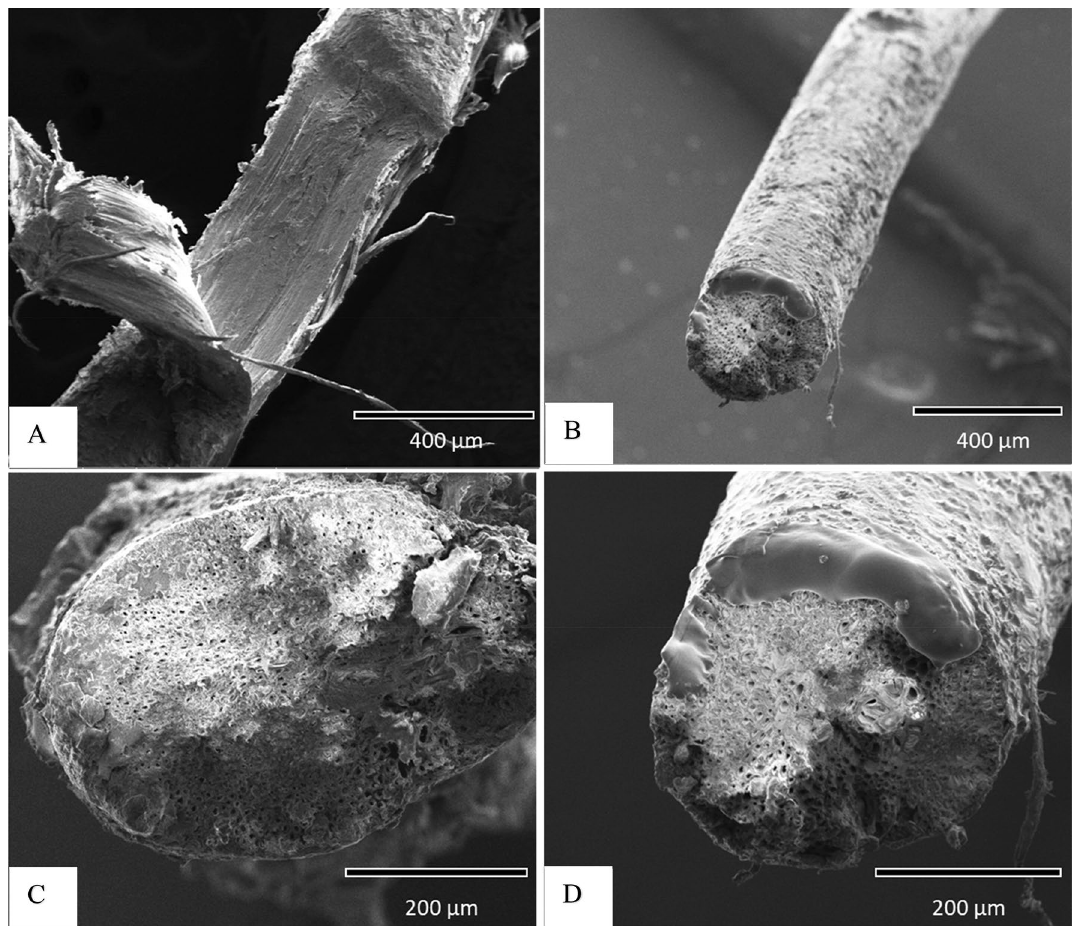
Figure 5. SEM of the longitudinal surfaces of ( A ) raw DPF and ( B ) C8-DPF, the cross sections of ( C ) raw DPF and ( D ) C8-DPF.